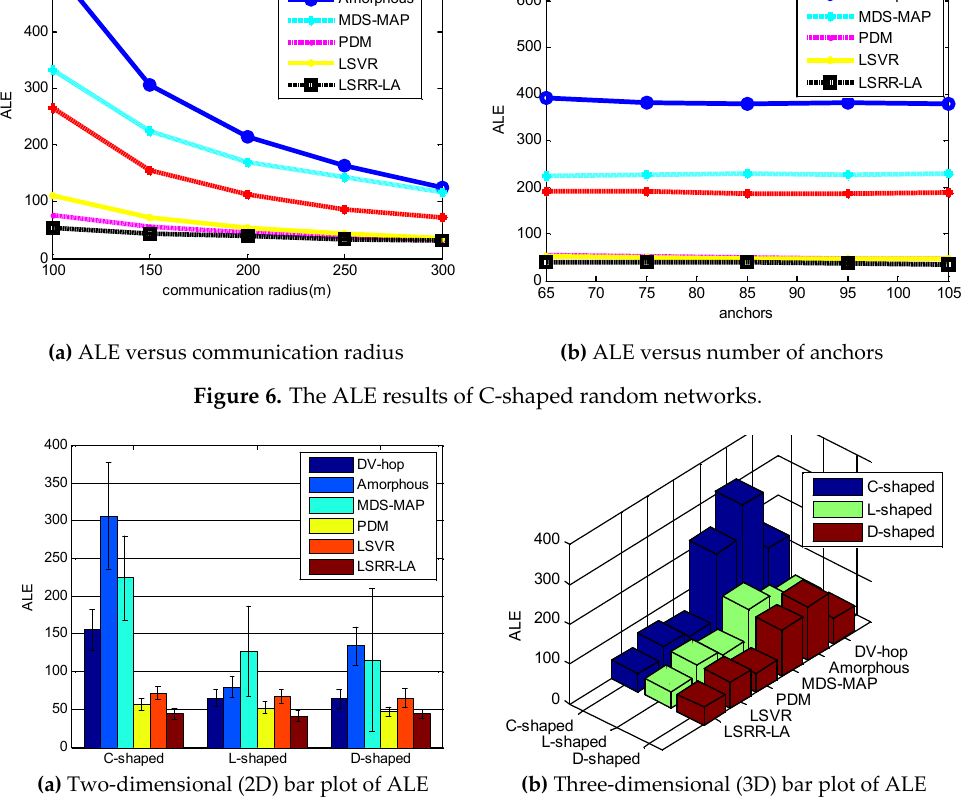
Figure 7. Comparison of ALE when R = 150m and M = 70.